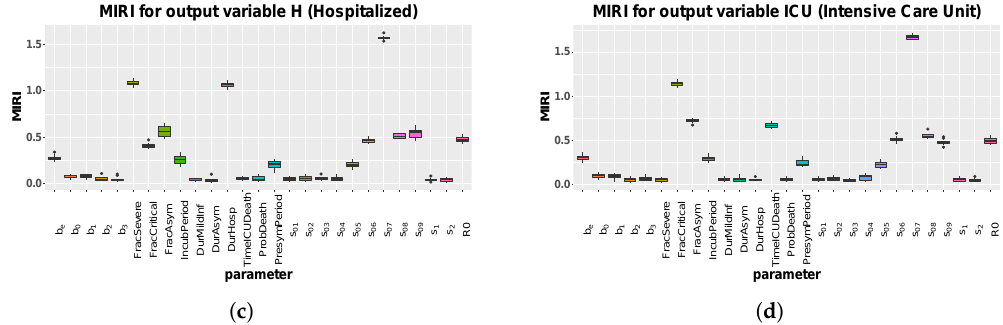
Figure 5. Italy: boxplot of the 10 realizations of the MIRIs in output from the CRA for all model parameters. ( a ) Evaluation function: area under the curve of H. Stop time: 110. ( b ) Evaluation function: area under the curve of Intensive Care Unit (ICU). Stop time: 110. ( c ) Evaluation function: area under the curve of H. Stop time: 300. ( d ) Evaluation function: area under the curve of ICU. Stop time: 300.